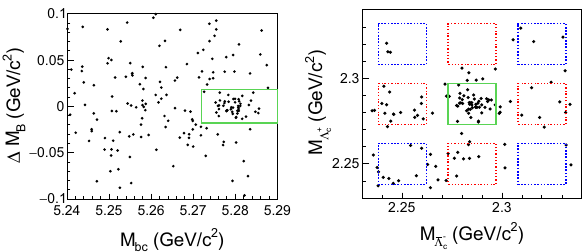
Fig. 1 Signal-enhanced distributions of (cid:11) M B versus M bc (left panel) and of M ( ¯ (cid:4) − c ) versus M ((cid:4) + c ) (right panel) from the selected ¯ B 0 → ¯ K 0 (cid:4) + ¯ (cid:4) − c c candidates, summing over all three reconstructed modes. Each panel shows the events falling in the solid green signal regionoftheotherpanel.Thedashedredandblueboxesintheleftpanel show the defined (cid:4) c sideband regions described in the text, which are used for the estimation of the non- (cid:4) c